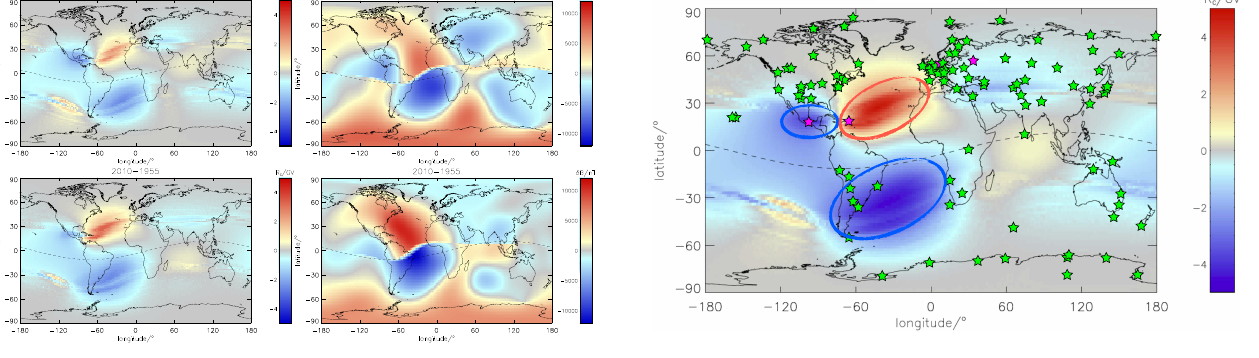
δB (right panels) for Moscow and Kiel (given as red and black dots, respectively) in the upper panels, while Mexico City (black dots) and BVI (red dots) are displayed in the lower panels. Reviewing this information, the following